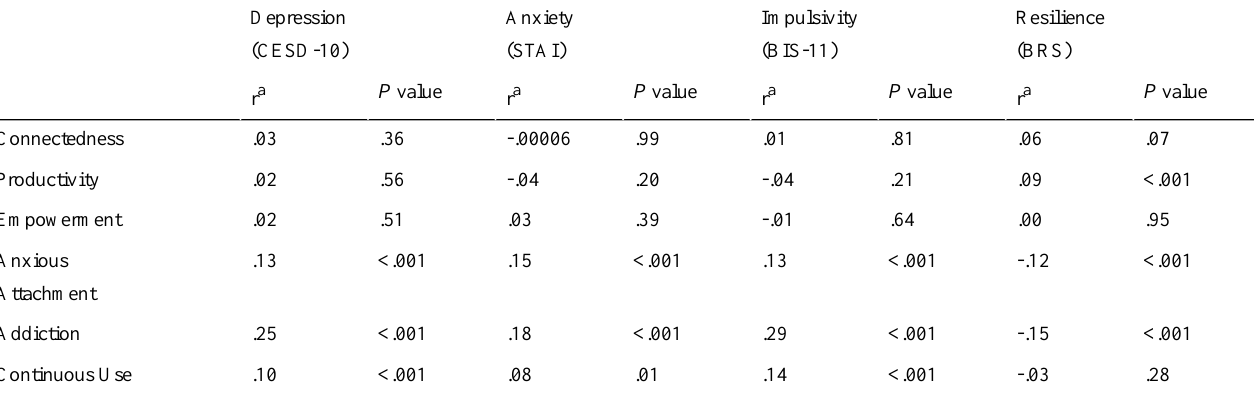
Table 4. Correlations for complete sample among the 6 Mobile Phone Affinity Scale (MPAS) scores and Centers for Epidemiologic Studies Depression Scale (CESD), State-Trait Anxiety Inventory (STAI), Barratt Impulsiveness Scale (BIS-11), and Brief Resilience Scale